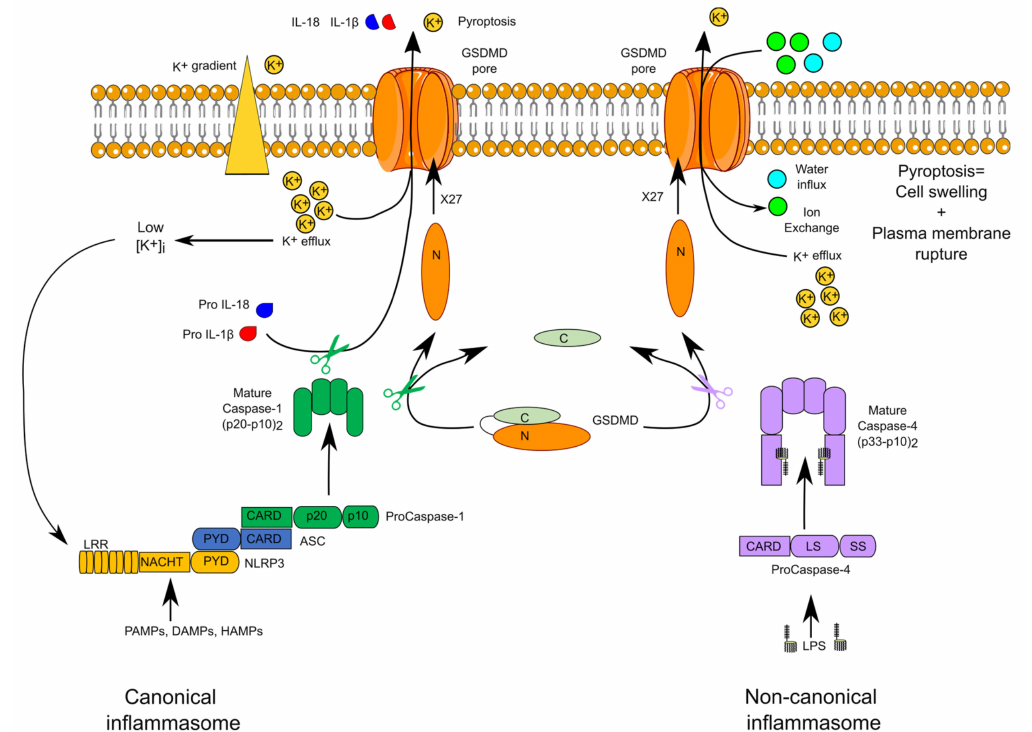
Figure 1. Canonical and noncanonical inflammasomes. The schematic structure of the canonical NLRP3 and noncanonical caspase-4 inflammasomes are displayed. Mature self-cleaved caspase-1 and caspase-4 cleave gasdermin D (GSDMD) leading to oligomerization of the N-terminal fragment in the membrane. The GSDMD pore promotes IL-1 β and IL-18 secretion and K + e ffl ux. The latter activates the NLRP3